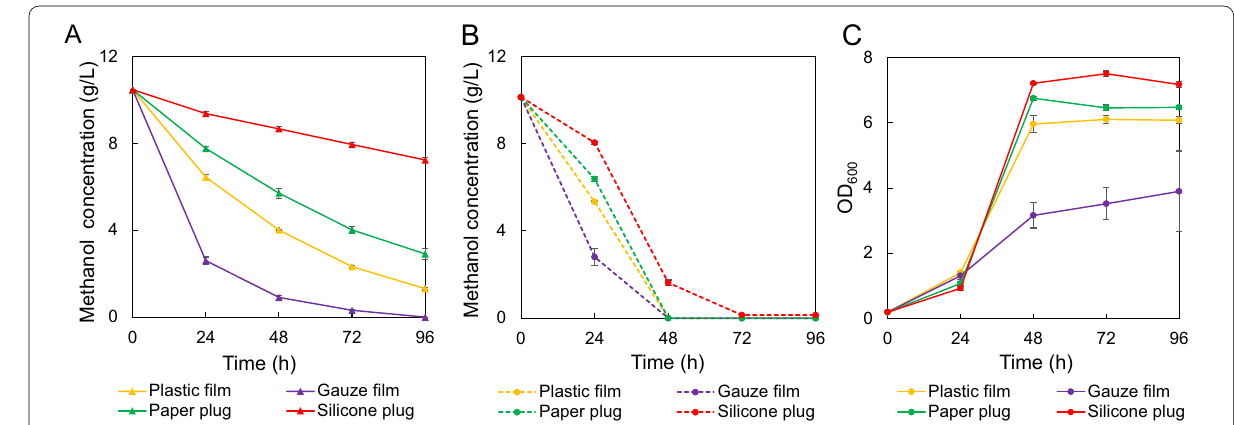
Fig. 3 Effects of different types of plugs on methanol volatilization and strain growth. A Effect of different types of plugs on methanol volatilization without cell growth. B Methanol concentration of strain 495–3 in four types of plugs: Plastic film, Gauze film, Paper plug, silicone plug. C Growth of strain 495–3 in different types of plugs. The fermentation was carried out in minimal medium containing 10 g/L methanol at 37 °C 220 rpm for 96 h. Data are presented as mean s.e.m. (n 3 biologically independent ± =